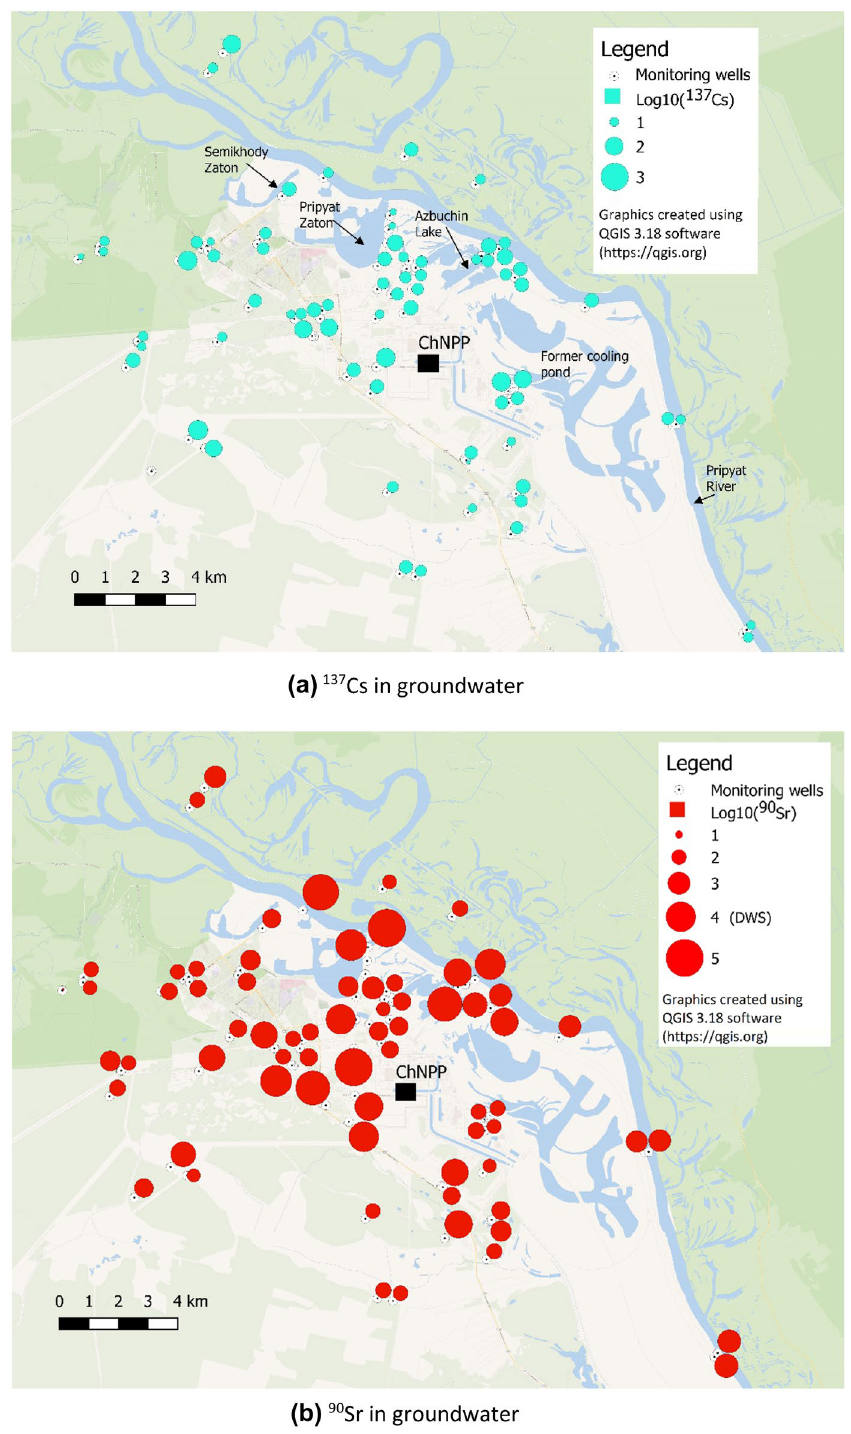
Figure 3. Distribution of 137 Cs and 90 Sr in groundwater of the 10-km zone of ChNPP in 2019 (Log 10 — transformed yearly-averaged concentrations in Bq m −3 ). The WHO drinking water standard for these radionuclides is 1 × 10 4 Bq m −3